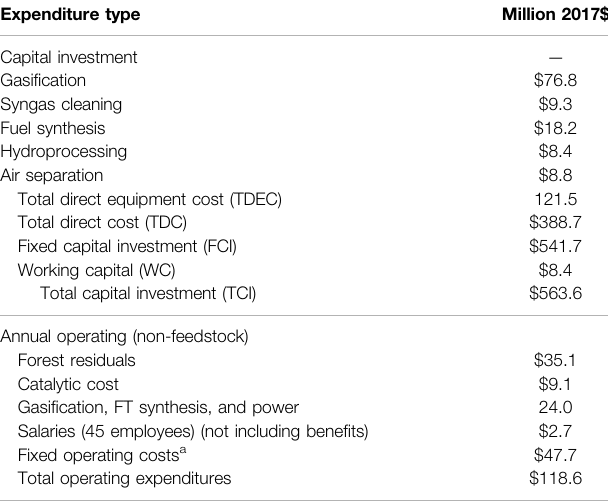
TABLE 9 | Summary of capital investment and annual operating costs for the gasi fi cation and Fischer – Tropsch conversion